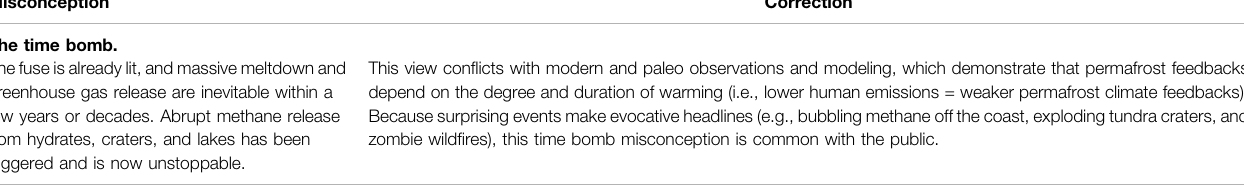
TABLE 1 | Clarifying common misconceptions about permafrost-climate interactions. Misconception